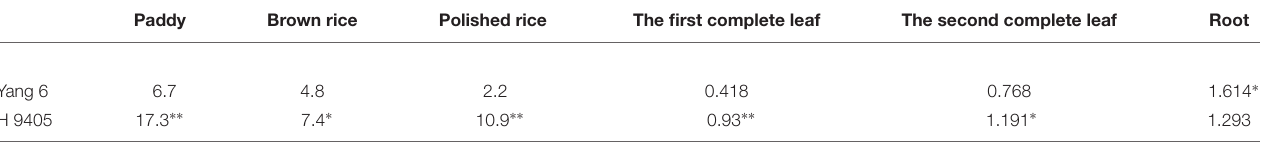
TABLE 1 | Fe content distribution in Yang 6 and H 9405 (mg/kg). Paddy